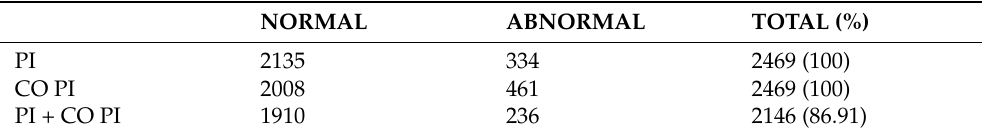
Table 1. Screening of smartphone photographs by the investigators.